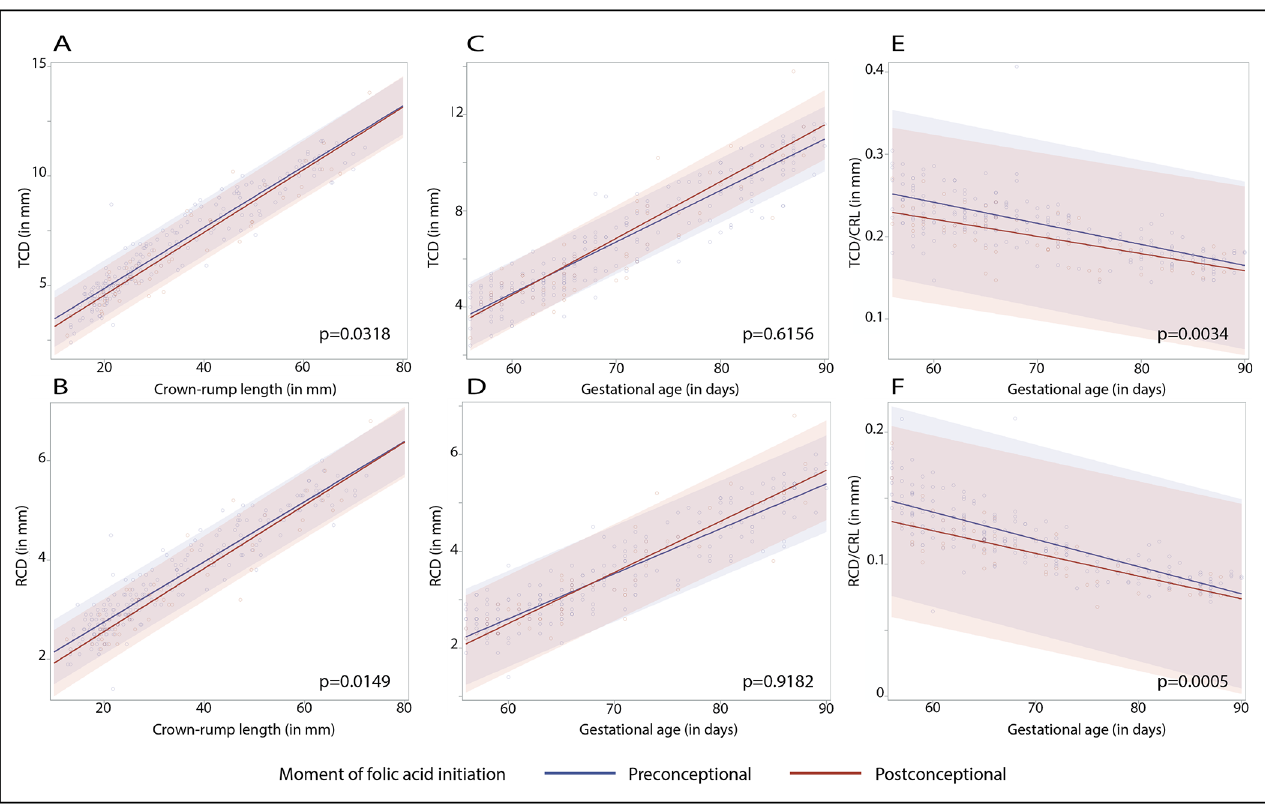
Fig 2. Longitudinal cerebellar measurements and proportional growth by folic acid initiation. Adjusted linear mixed models representing the effects of preconceptional compared to postconceptional initiation of folic acid supplement use on cerebellar size and growth trajectories as function of CRL in millimetres (A and B) and GA in days (C and D) and proportional cerebellar growth trajectories (E and F).